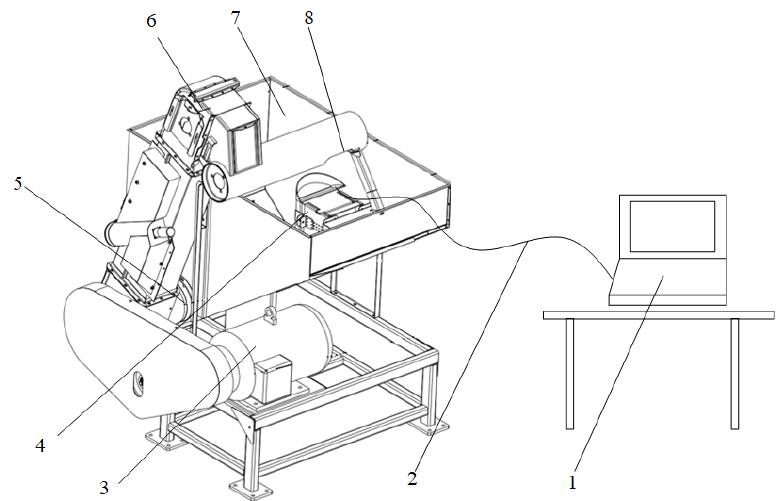
Figure 4. Bench verification test. (1 computer; 2 system bus; 3 motor; 4 wheat impurity rate detection device; 5 auger; 6 scraper elevator; 7 grain tank; 8 discharge hopper.)